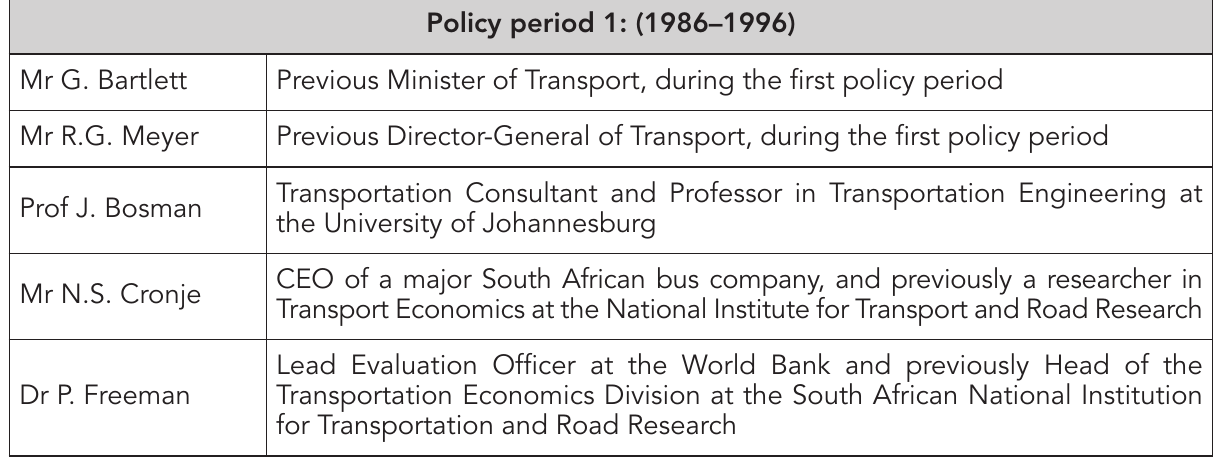
Table A2: Purposively selected participants for the field survey in the qualitative analysis of the transport policy-making process in South Africa during the two policy periods addressed in this